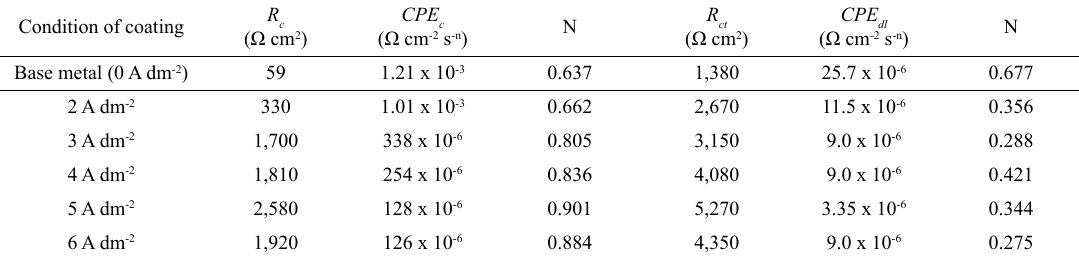
Table 5. Electrochemical parameters fitted from EIS measurement for the electrolyte/coating and electrolyte/base metal systems. Condition of